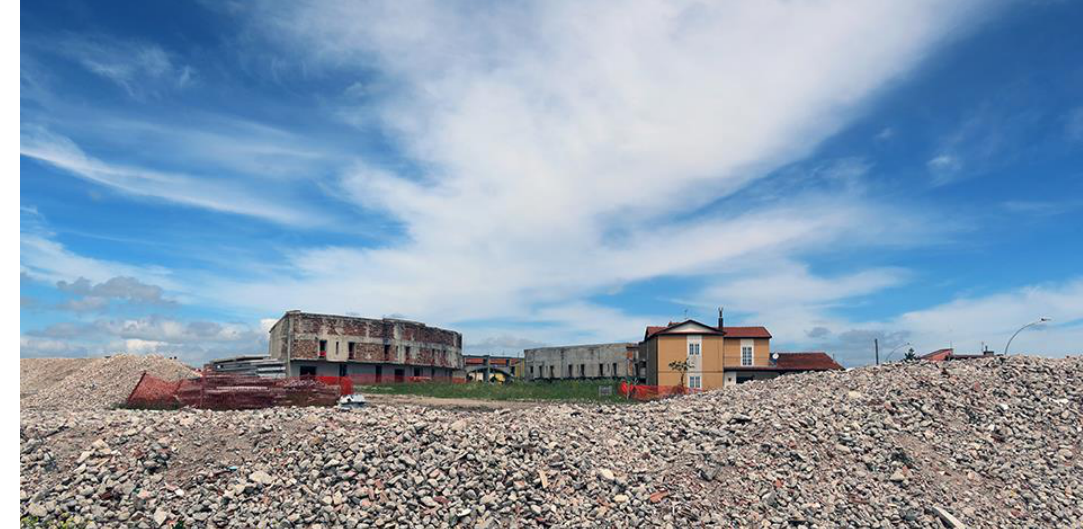
Figure 108. Bisaccia: the new village (Piano di Zona) with the remains of the new social housing still to be completed (Istituto Autonomo Case Popolari-IACP). A part of them has been demolished in 2020 (photos by [41]).